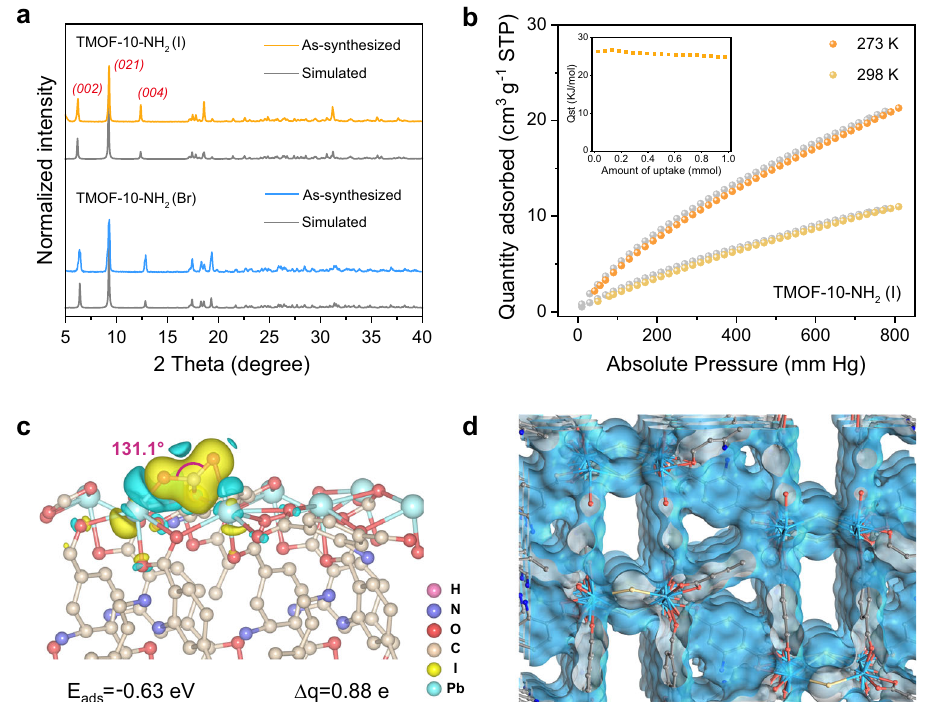
Fig. 2 | PXRD and CO 2 sorption of TMOF-10-NH 2 . a Experimental and simulated PXRDpatternsforTMOF-10-NH 2 . b CO 2 absorptionisothermsofTMOF-10-NH 2 (I)at 273K and 298K.Insetis the Qst ofCO 2 absorption. c Differentialchargedensity of